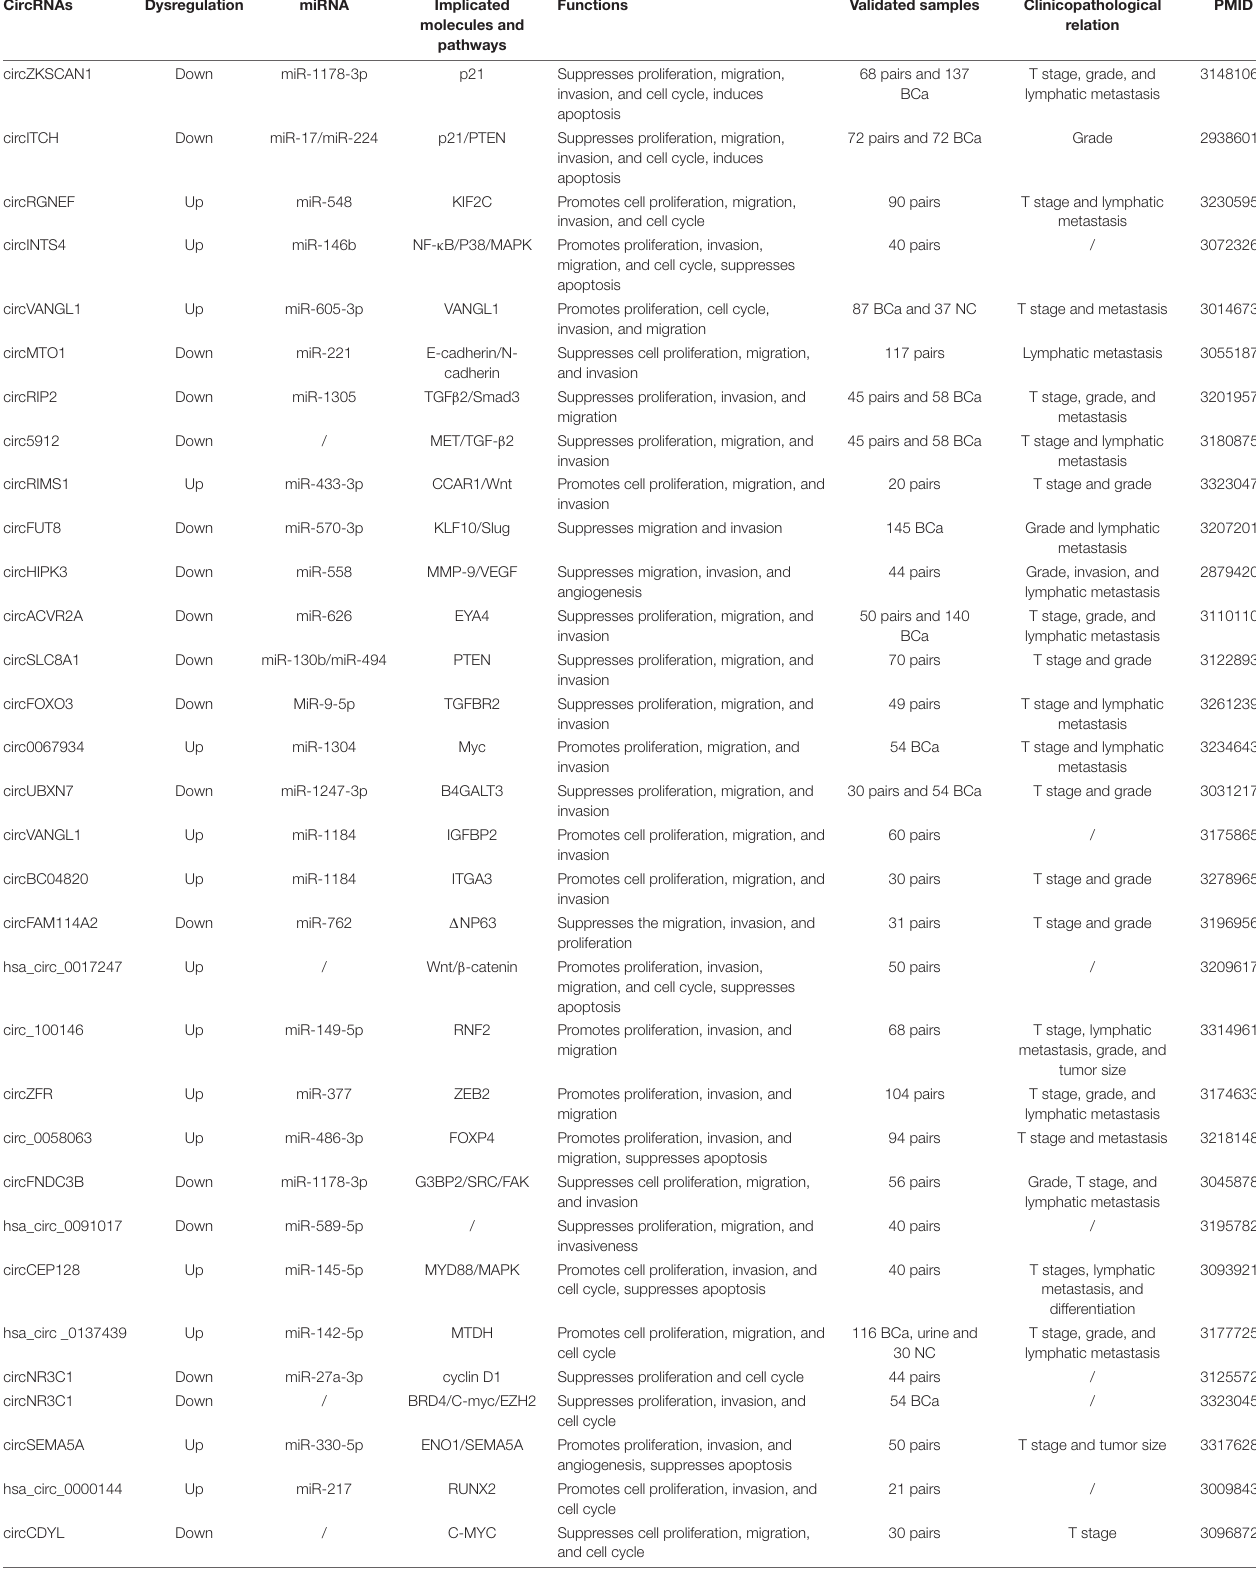
TABLE 1 | Overview of dysregulated circRNAs in